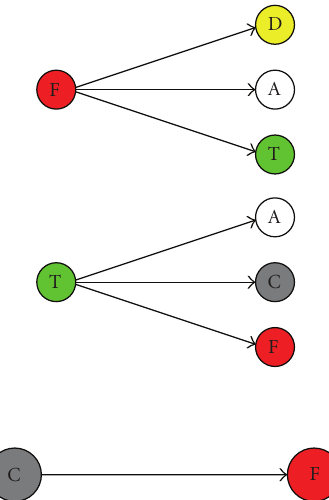
Figure 1: The possible reactions which the three di ff erent particles can undergo. Fast neutrons (red circle) can be detected (yellow), absorbed (white), and thermalized (green). Thermal neutrons (green) can be absorbed, and through fission lead to a random number of delayed neutron precursors (grey) and fast neutrons (red). Delayed neutron precursors decay into a fast